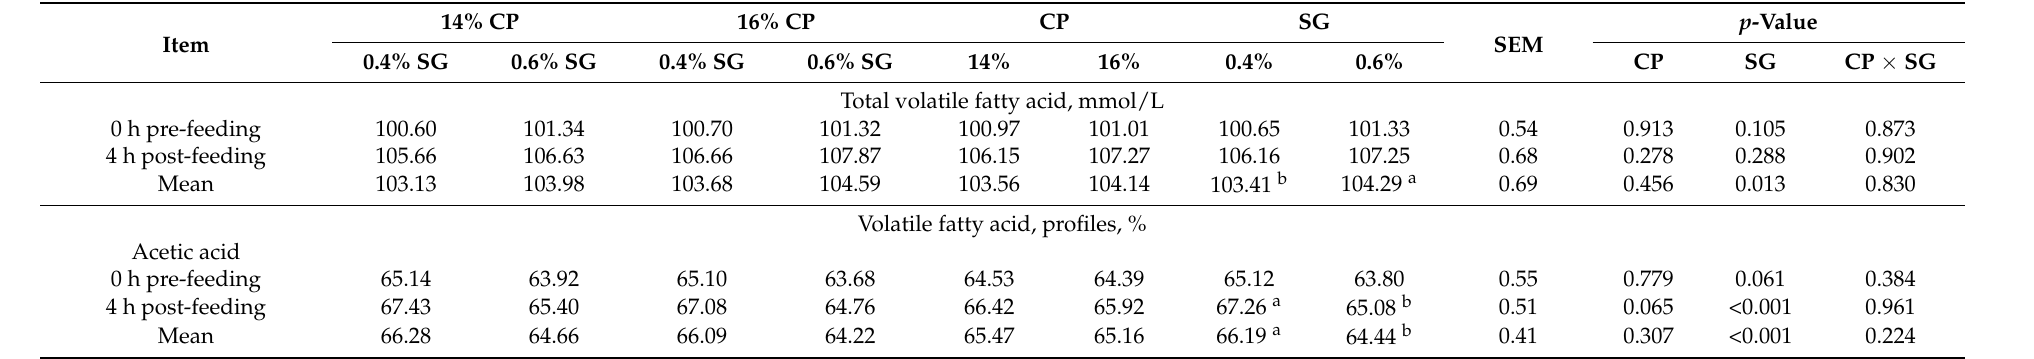
Table 5. Effects of crude protein (CP) levels (14% vs. 16%) in concentrate with S. graniflora pod meal (SG, 0.4% vs. 0.6% dry matter intake) on volatile fatty acid profile and methane estimation in Thai native beef